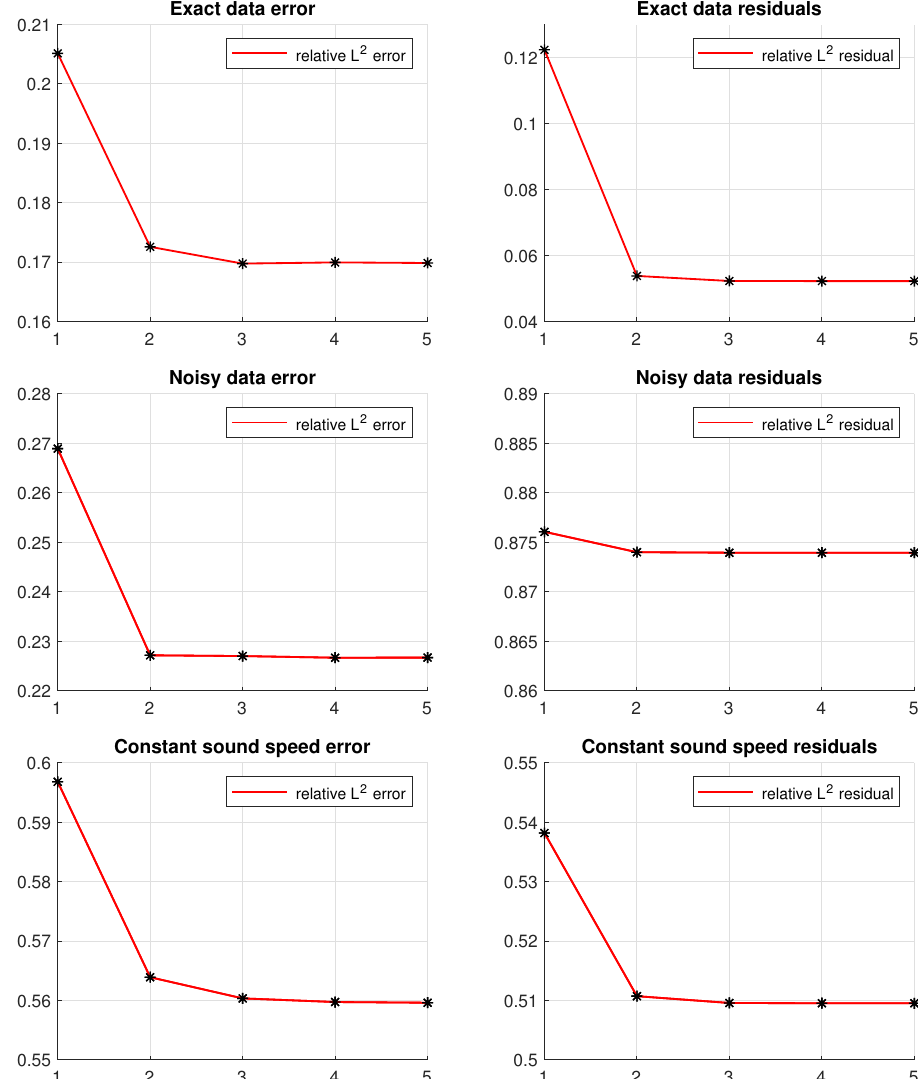
Figure 7. R ELATIVE RECONSTRUCTION ERROR ( LEFT ) AND RELATIVE RESIDUALS ( RIGHT ). ( Top ): Simulated data and correct sound speed. ( Middle ): Noisy data and correct sound speed. ( Bottom ): Simulated data and wrong sound speed (constant and equal to